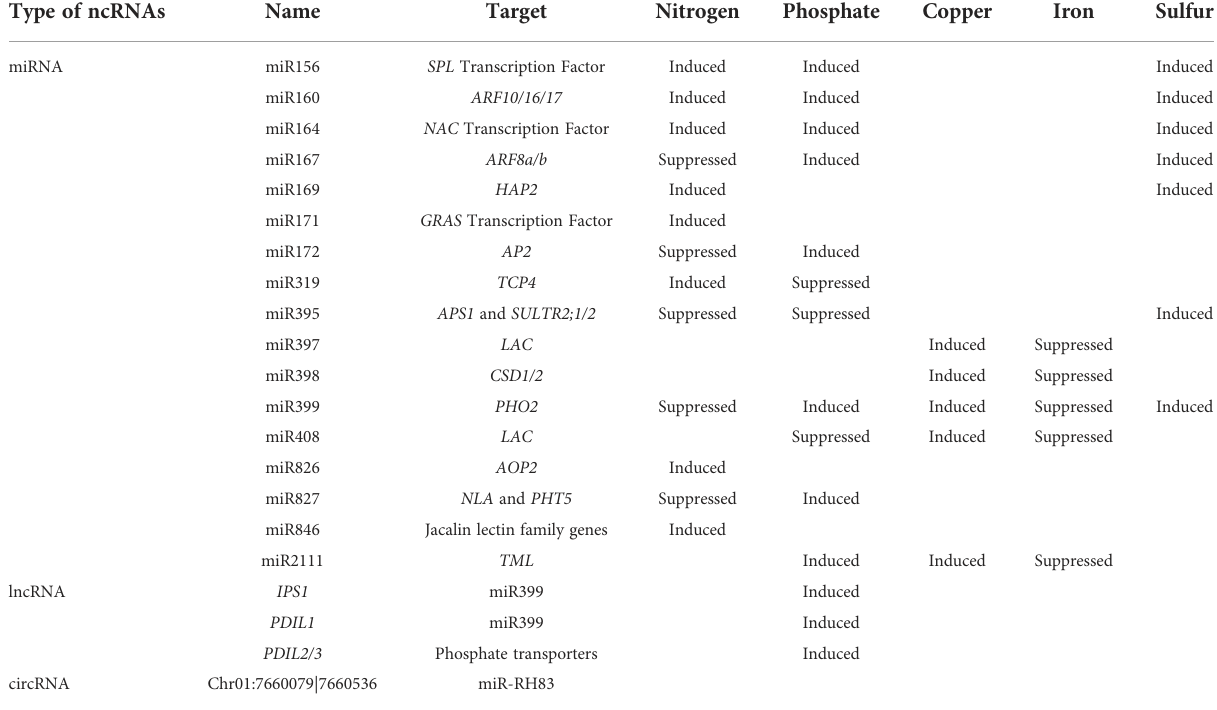
TABLE 2 NcRNAs involved in nutrient starvation